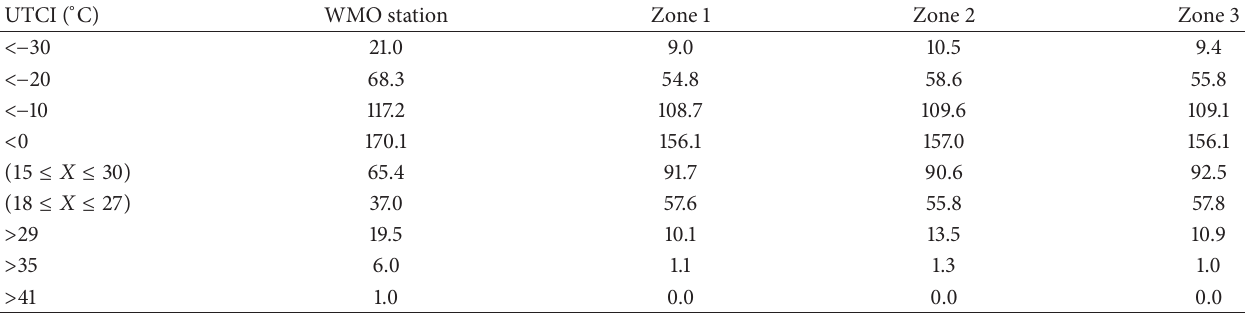
Figure 7: Monthly and daily dynamics of thermal comfort in winter (January) and summer (July) calculated with UTCI for Birobidzhan, zone 1. Table 3: Mean number of days per year with UTCI values within a specific class for the 3 zones as well as for the climate station in Birobidzhan